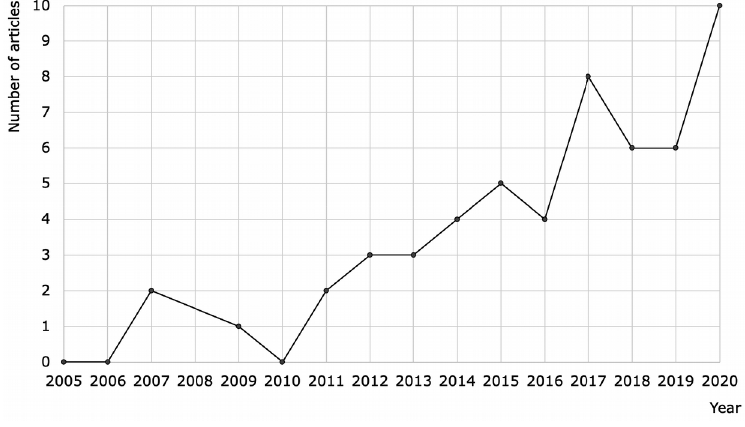
Figure 2. Distribution of the 54 selected papers over the years